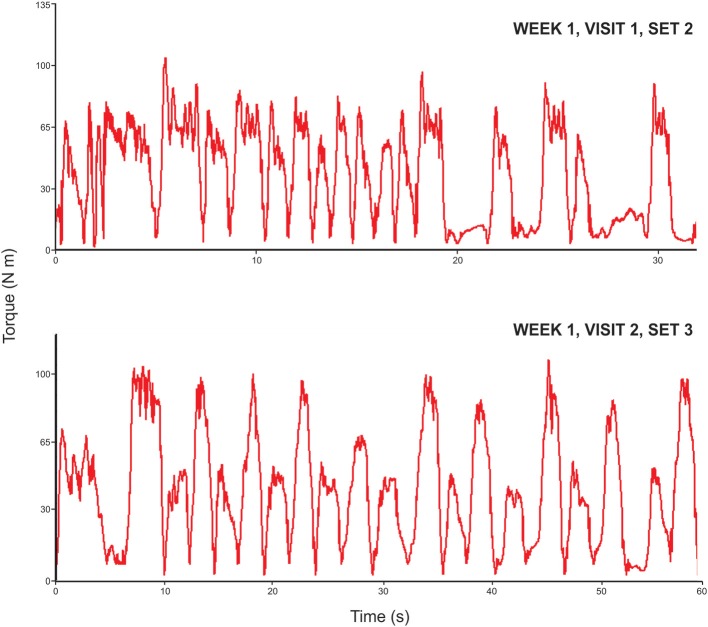
Eccentric torque-time curves during the familiarization phase of the strength training program. The exemplar data shows the transition in the isokinetic eccentric motor performance (in the 45°/s exercise condition) observed during the familiarization phase of the strength training program. The torque-time curve for knee extension and flexion observed during session one exhibits a high degree of variability based on the eccentric knee extension mean repetition interval time (coefficient of variation, CV = 68%). However, this variability decreases by the end of the familiarization phase during session two (CV = 12%).